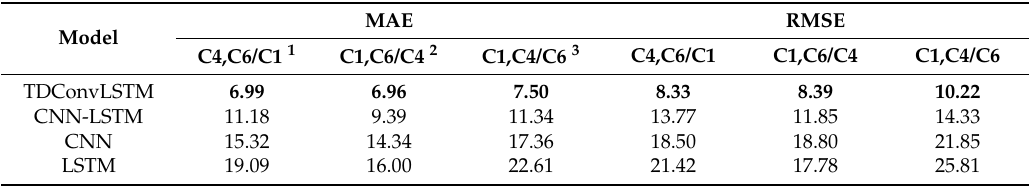
Table 5. Mean absolute error (MAE) and root mean square error (RMSE) of models.